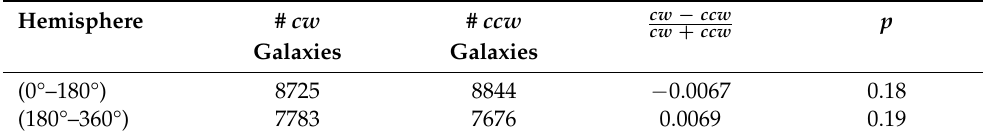
Table 5. Number of clockwise and counterclockwise galaxies in opposite hemispheres in Pan-STARRS.